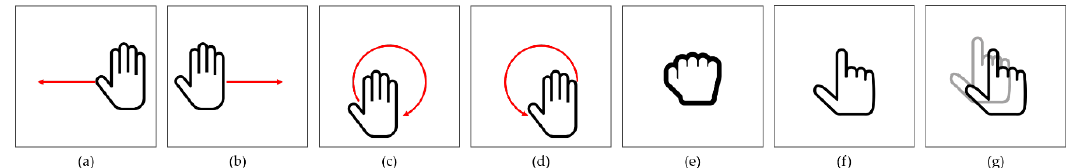
Figure 15. Seven hand gestures for the proposed system: ( a ) swipe left (SL); ( b ) swipe right (SR); ( c ) clockwise rotation (CR); ( d ) counter-clockwise rotation (CCR); ( e ) grab (G); ( f ) push (P); ( g ) double push